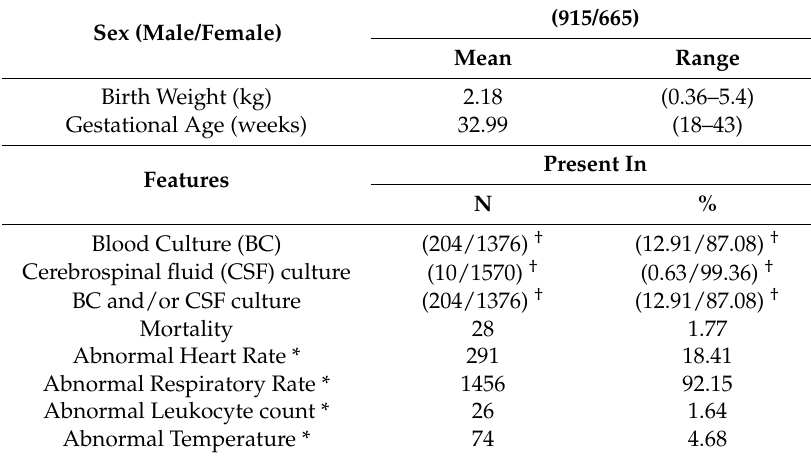
Table 2. Baseline characteristics of neonates ( N = 1580).